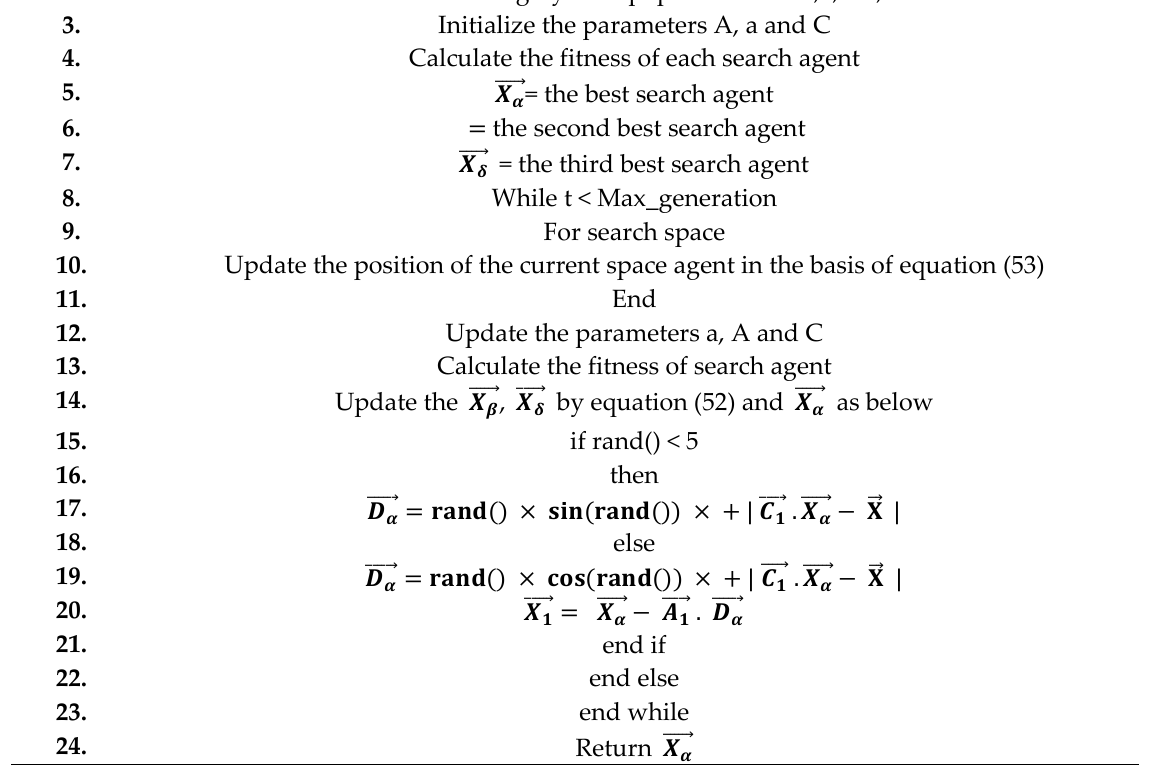
Figure 8. pseudo-code of the hybrid grey wolf optimiser-sine cosine algorithm (HGWOSCA). Figure 8. Pseudo-code of the hybrid grey wolf optimiser-sine cosine algorithm